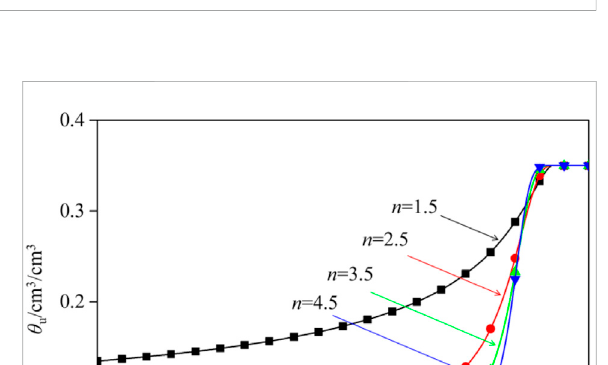
FIGURE 6 Effect of desalination on the SFCC.